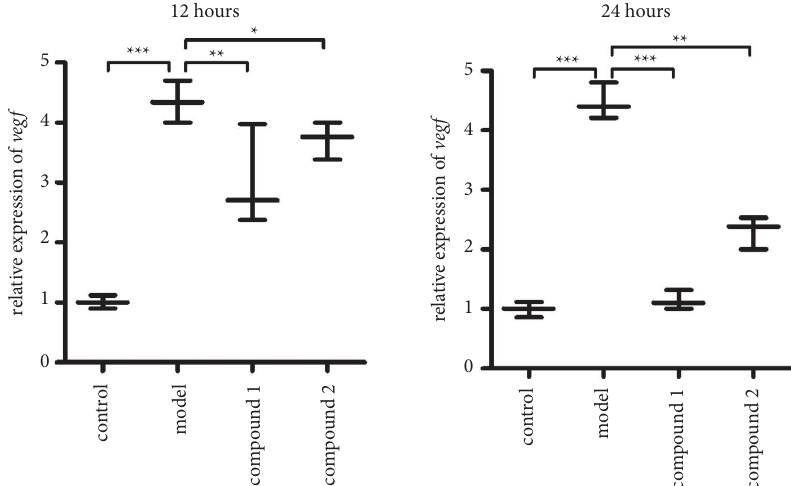
Figure 6: Evidently suppressed VEGF signal pathway activation in HaCaT cells after treating via the compound. The complexes were employed for treating HaCaT cells with specific concentrations. The real-time RT-PCR was conducted and the VEGF signal pathway activation in HaCaT cells was examined. ∗ means P < 0 . 05, ∗∗ means P < 0 . 01, and ∗∗∗ means P < 0 .